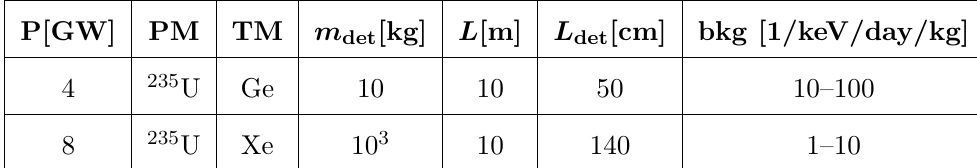
Table 4 . Production and detection parameters used in our analysis. Upper values refer to current (or near-future) experiments, while those in the lower row to a next-generation experiment. These values — used for definitiveness — should be understood as representative of the actual experimental parameters shown in tables 1 and 3. P refers to power, PM to production material and TM to target material. Our analysis includes two background hypotheses and we assume the detector to be 100%